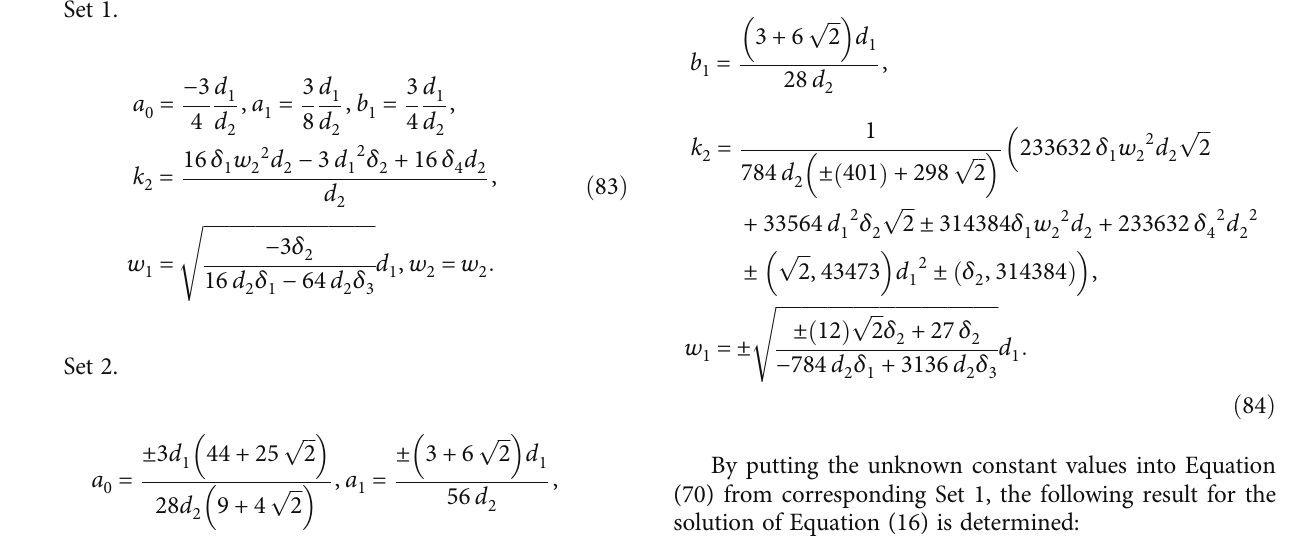
ð x , t Þj for NLFD of order α and for parameters δ 2